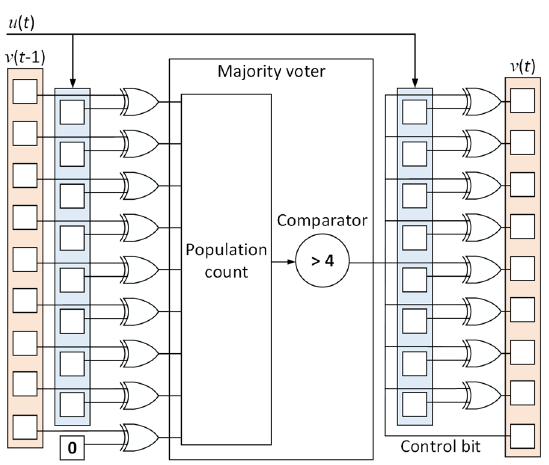
Figure 1. Conventional 8-bit DBI encoding when u ( t ), v ( t − 1), v ( t ) are the current data, the previous codeword, and the current codeword.